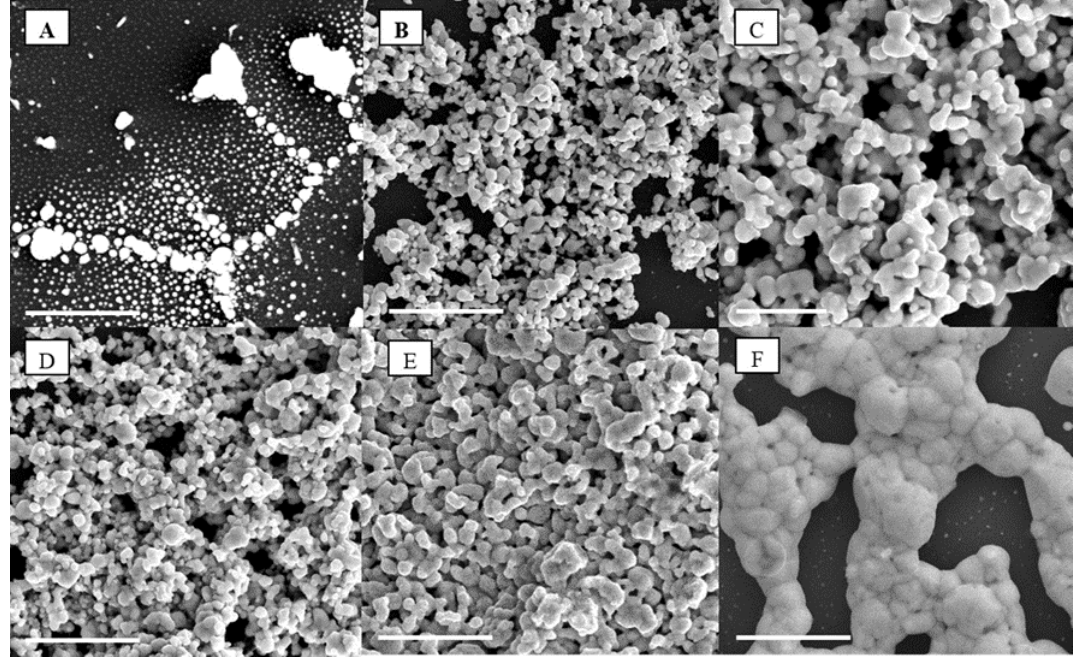
Figure 5. Scanning electron microscope (SEMs) of the silver NPs percolation threshold for ( A ) 1 wt %, ( B ) 4 wt %, ( C ) 10 wt %, ( D ) 20 wt %, ( E ) 30 wt %, and ( F ) 50 wt % after annealing in air at 250 °C; the scale bar on all images corresponds to 5